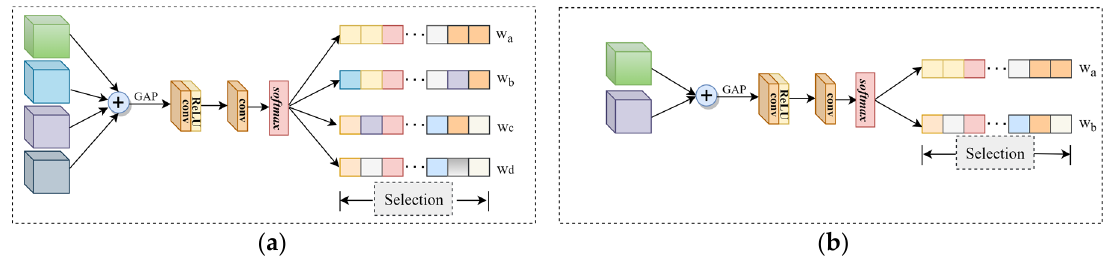
Figure 3. Speci fi c structure of the FSM. The structure of the FSM of the fi rst and second layers is Figure 3. Specific structure of the FSM. The structure of the FSM of the first and second layers is shown in ( a ), and the third layer is shown in ( b ). shown in ( a ), and the third layer is shown in ( b ).